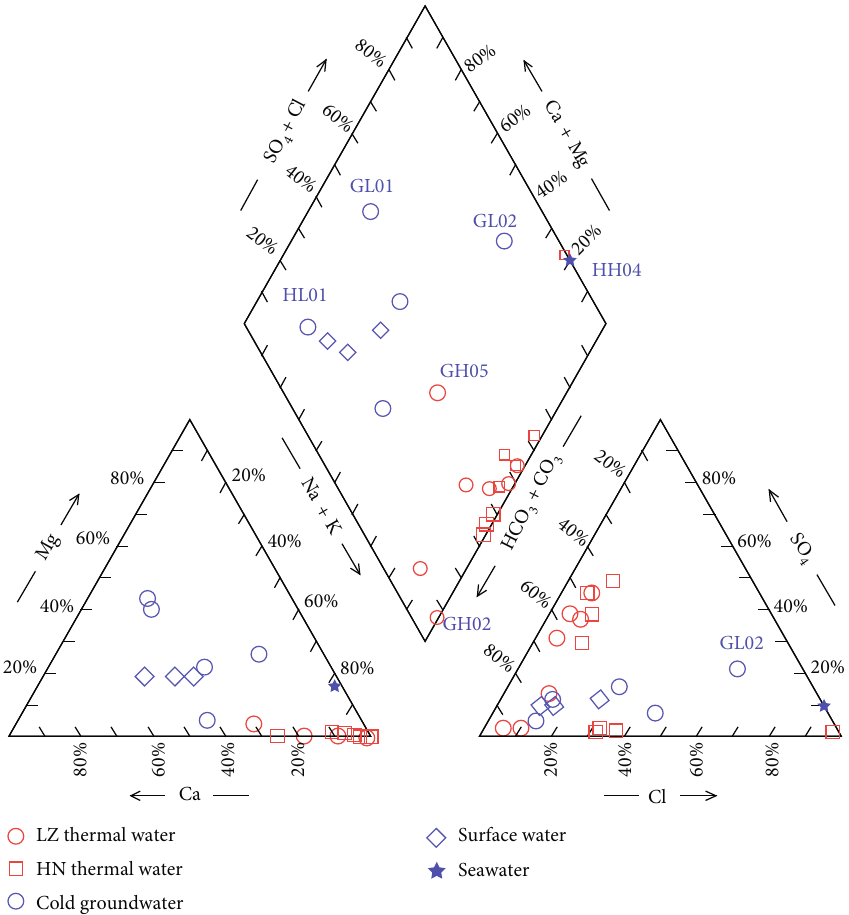
Figure 2: Piper diagram showing the water samples in the study